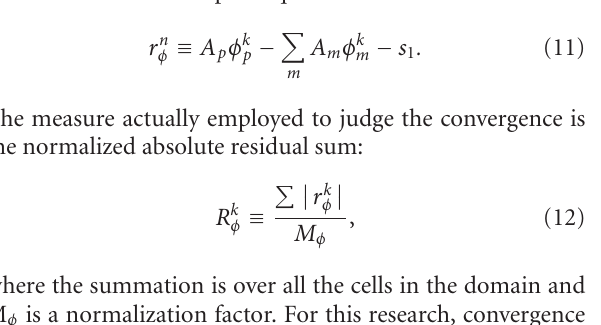
Figure 6: Mesh for the two-dimensional simulation.